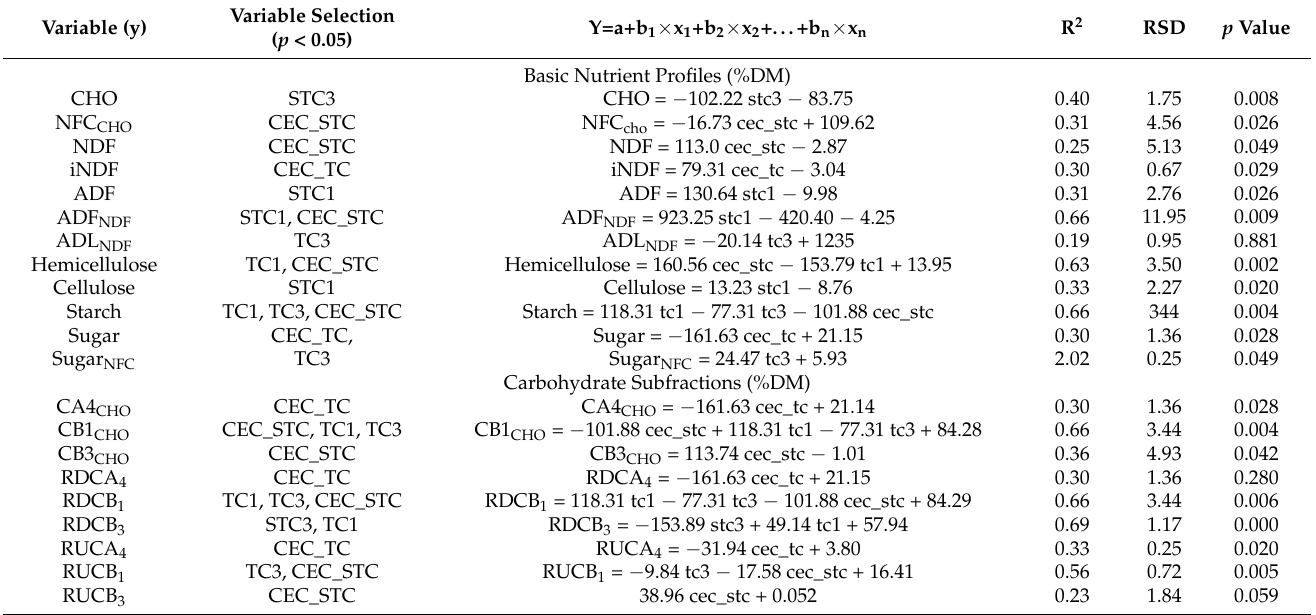
Table 6. Multiple Regression Analysis to Study Associations between Carbohydrate Spectral Parameters and Carbohydrate Chemical Profiles and Nutrition Values of Cool-Season Adapted CDC Chickpeas. Variable (y)